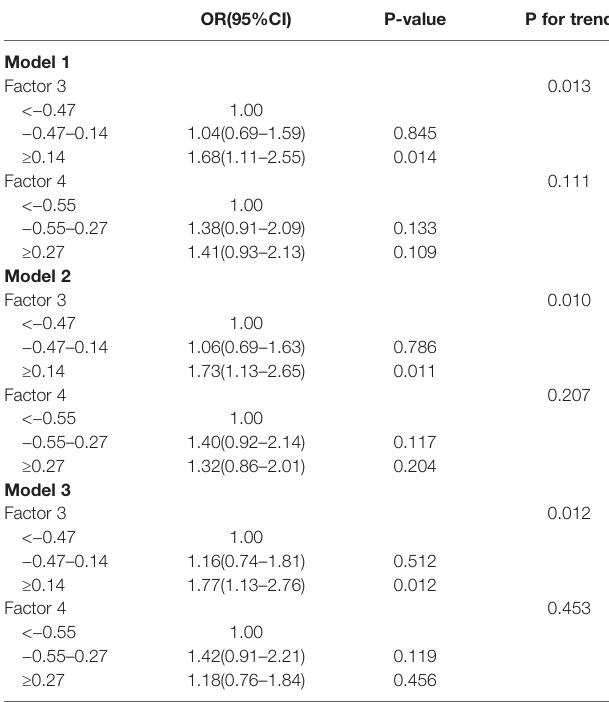
TABLE 5 | Adjusted odds ratio of factors for CVD risk in